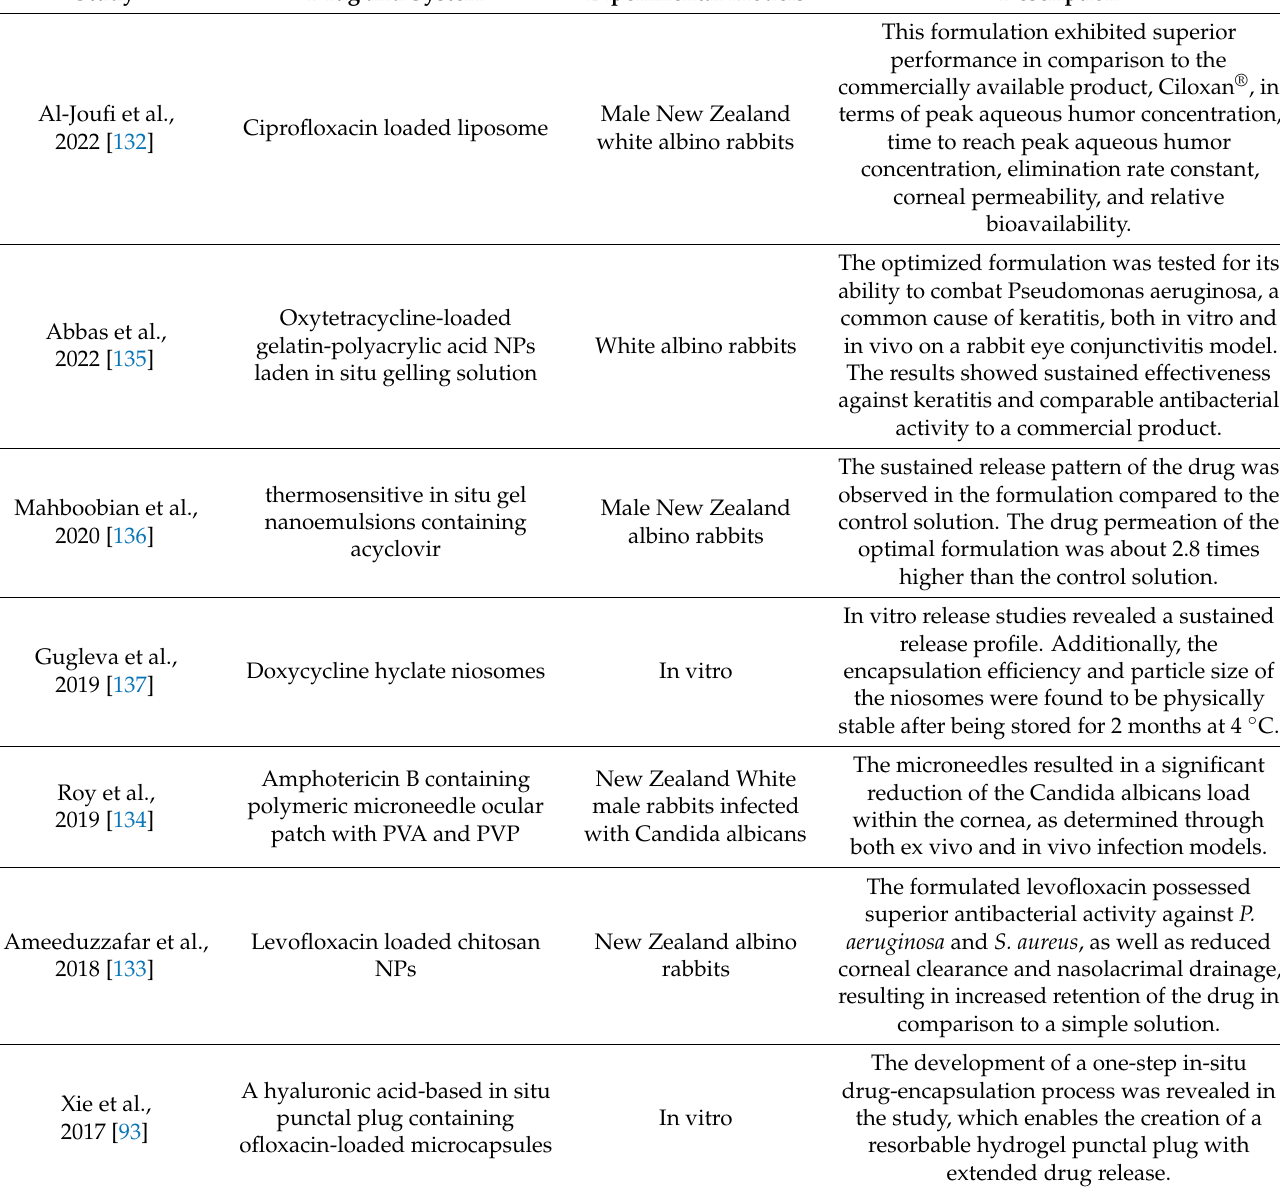
Table 2. Studies of biodegradable formulations for ocular